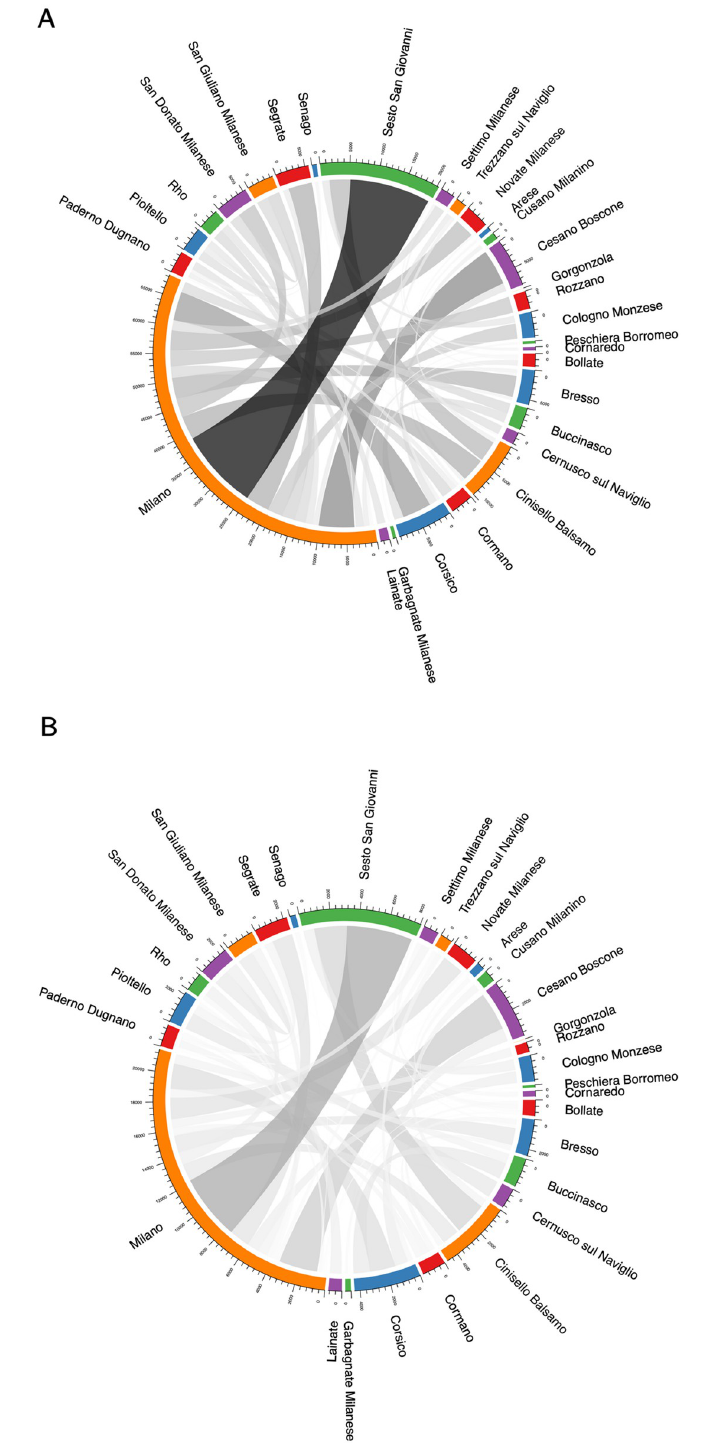
Fig 2. Mobility flows in the province of Milan. (A) and (B) show the mobility between municipalities in Milan province before (top) and during (bottom) lockdown, respectively. Color intensity indicates the amount of traffic (with darker edges corresponding to higher values), and the same normalization is used across the two diagrams. Properties of the mobility network [before, during] lockdown: Assortativity: [-0.062, -0.063]; Average Clustering Coefficient: [6.28e-05; 2.70e-05].